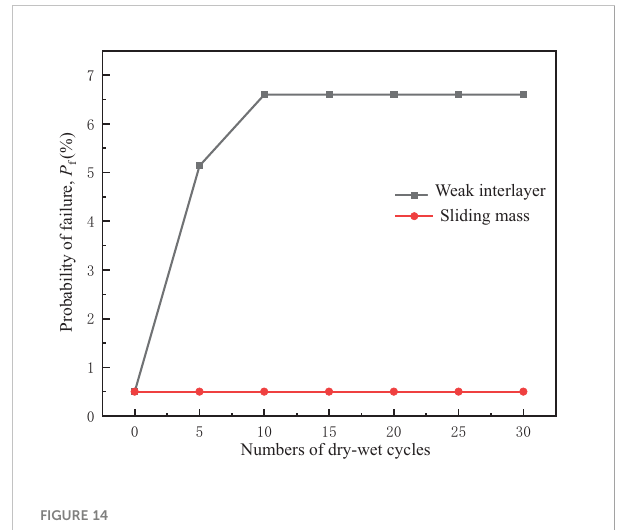
FIGURE 14 In fl uence of parameters degradation of only sliding mass or weak interlayer on failure probability under dry-wet